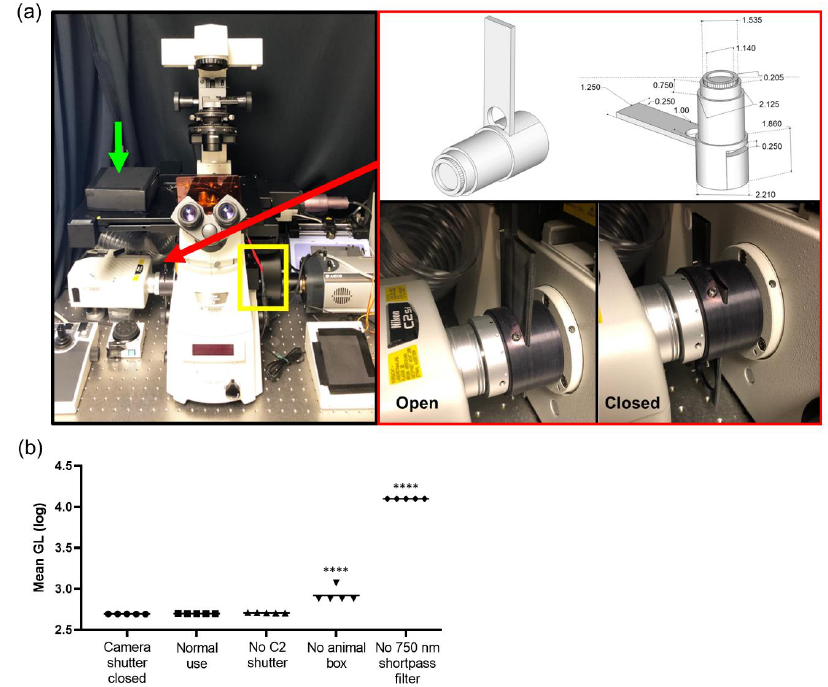
Figure 1. Intravital bioluminescence and fluorescence microscope configuration. ( a ) Photograph of microscope: charge-coupled device (CCD) camera on the right port, confocal system on the left port, yellow box indicates filter wheel, green arrow indicates black box placed over animal, and red arrow and red box show the manual shutter. ( b ) Quantification of light leakage throughout the system at every level of light elimination displayed with log scale (GL, grey level); **** p < 0.0001